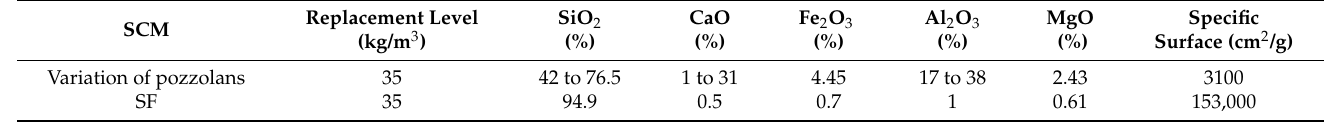
Table 11. The variation of the chemical properties of SCMs used to generate new